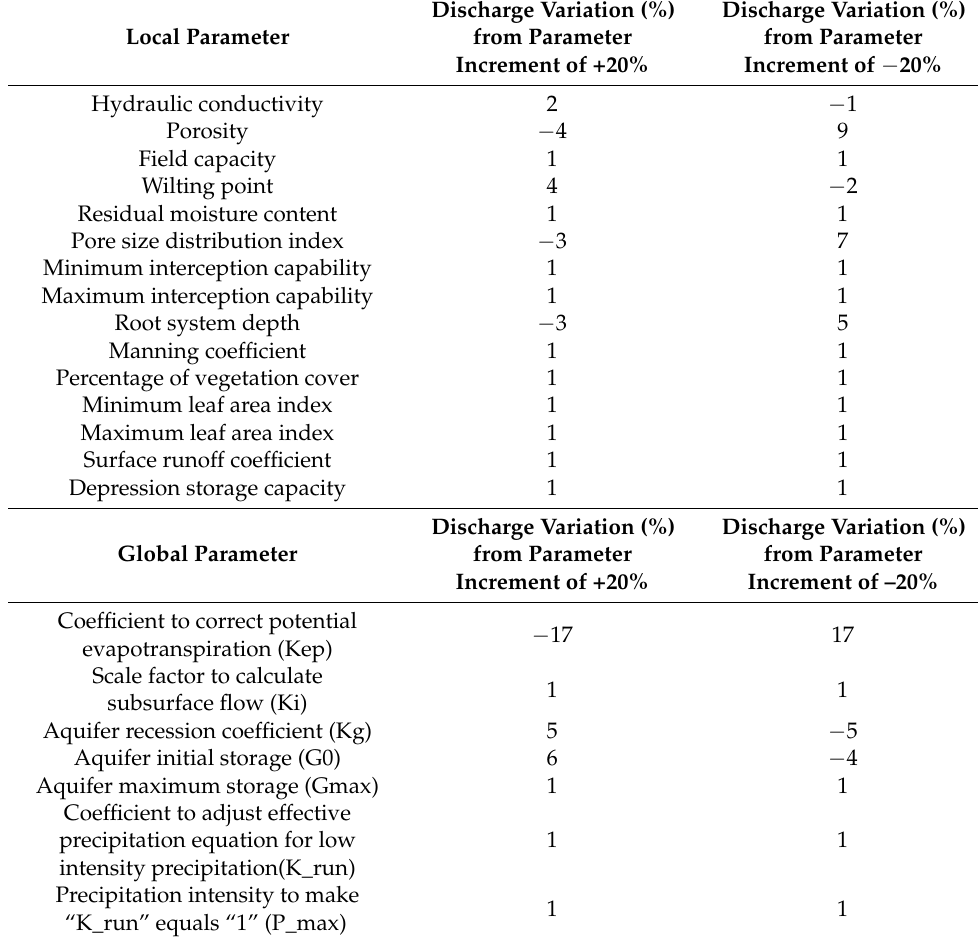
Table 3. Sensitivity analysis results.